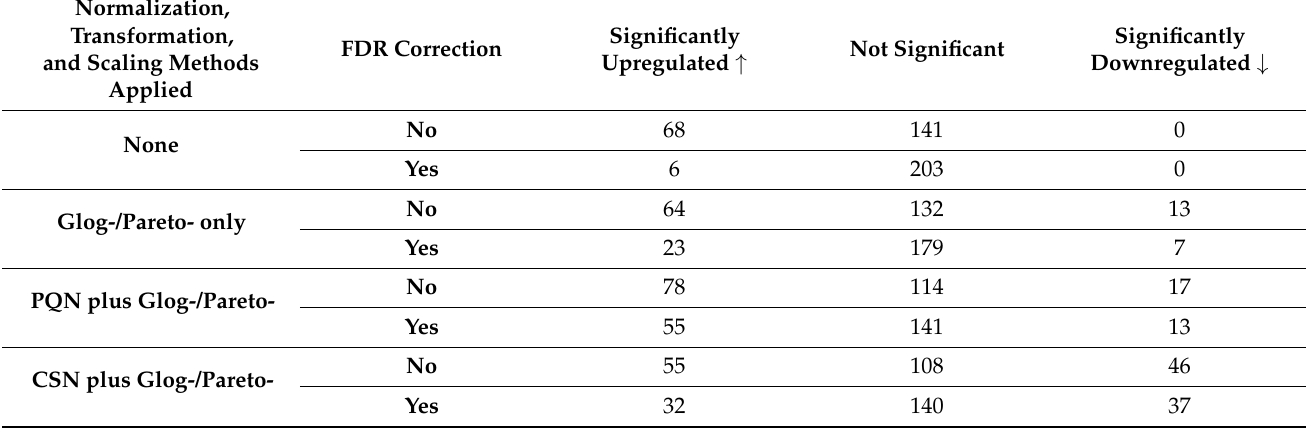
Table 3. Numbers of significant 1 H NMR ISB variables for UV two-sample t tests performed, both with and without false discovery rate (FDR) correction, on a total of 209 ISB variables from the sore-throat study dataset with different row-wise normalization, transformation, and column- wise scaling methods applied. Row-wise normalization methods used were either product quotient normalization (PQN) to an overall average healthy control group spectrum, or CSN. Where relevant, the transformation applied was a generalized logarithmic (glog) one, and the scaling strategy involved was Pareto-scaling. Up- and downregulations in ISB variables are those expressed with respect to the participants in the acute sore-throat condition group, i.e., a significant upregulation refers to a significantly higher mean ISB intensity value (and hence assigned metabolite salivary concentration) over that corresponding to the healthy control group, and vice-versa for